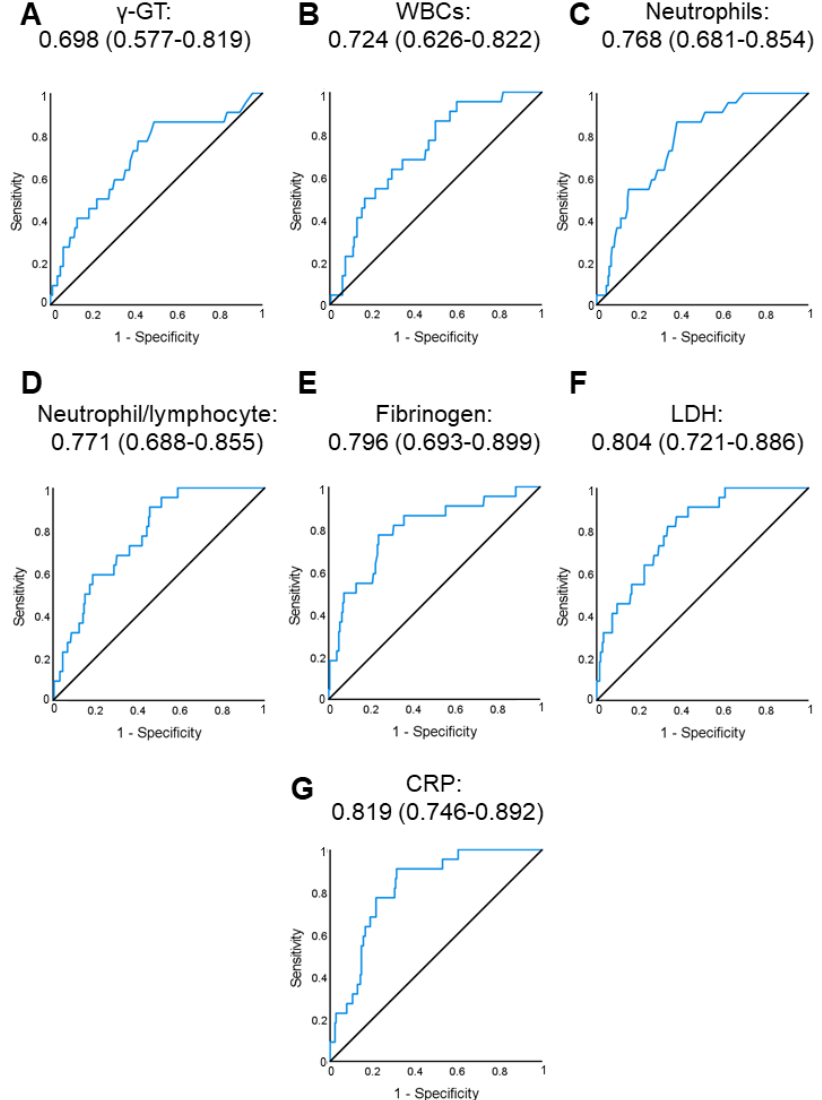
Figure 1. Receiver operating characteristic (ROC) analysis of gamma-glutamyl transferase ( γ -GT; ( A )), white blood cells ( B ), neutrophils ( C ), neutrophil-to-lymphocyte ratio ( D ), fibrinogen ( E ), lactate dehydrogenase (LDH; ( F )) and C-reactive protein (CRP; ( G )) for discriminating patients with critical vs. non-critical COVID-19 in the absence of comorbidities (derivation cohort). Numbers represent AUC (95% CI) for each parameter. Abbreviations: AUC: area under the curve, CI: confidence interval.